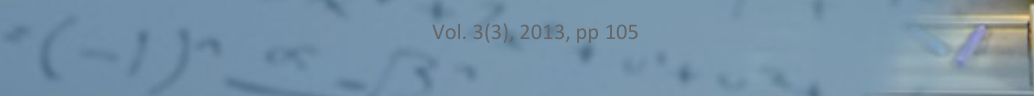
Vol. 3(3), 2013, pp